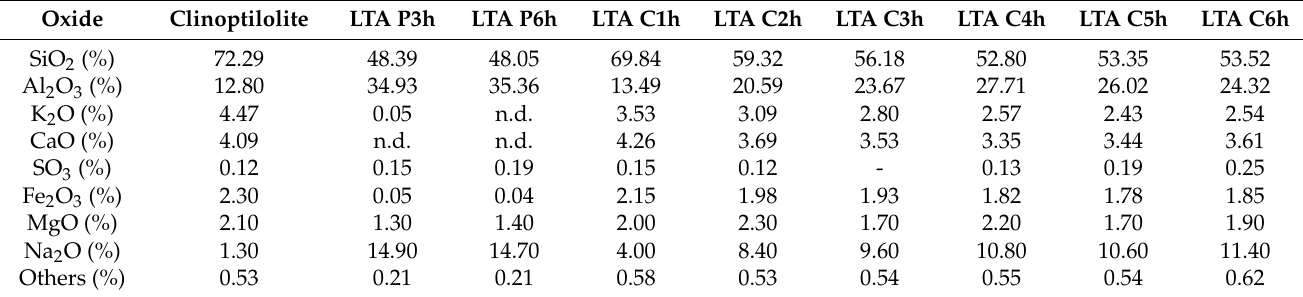
Table 3. Chemical composition (FRX) of standard LTA zeolites and LTA zeolites from clinoptilolite. Oxide Clinoptilolite